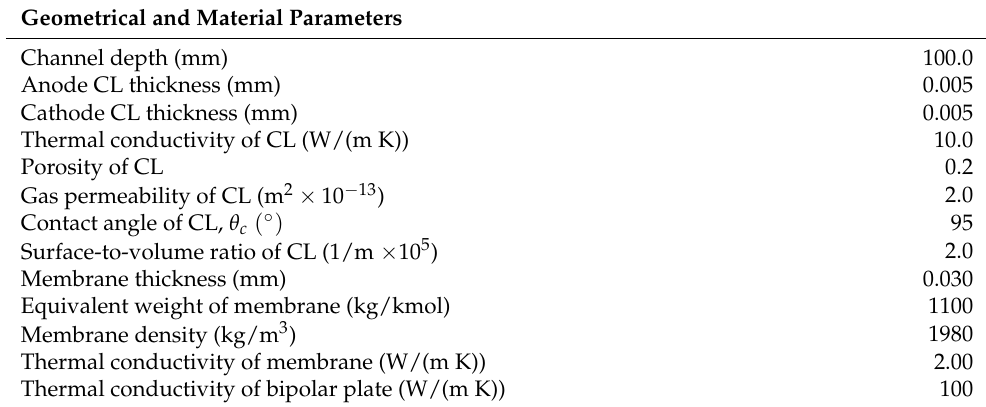
Table 2. Physical and transport properties of the rest of the PEMFC components not appearing in Table 3. Other than these, the value of the properties given in [19] were adopted.